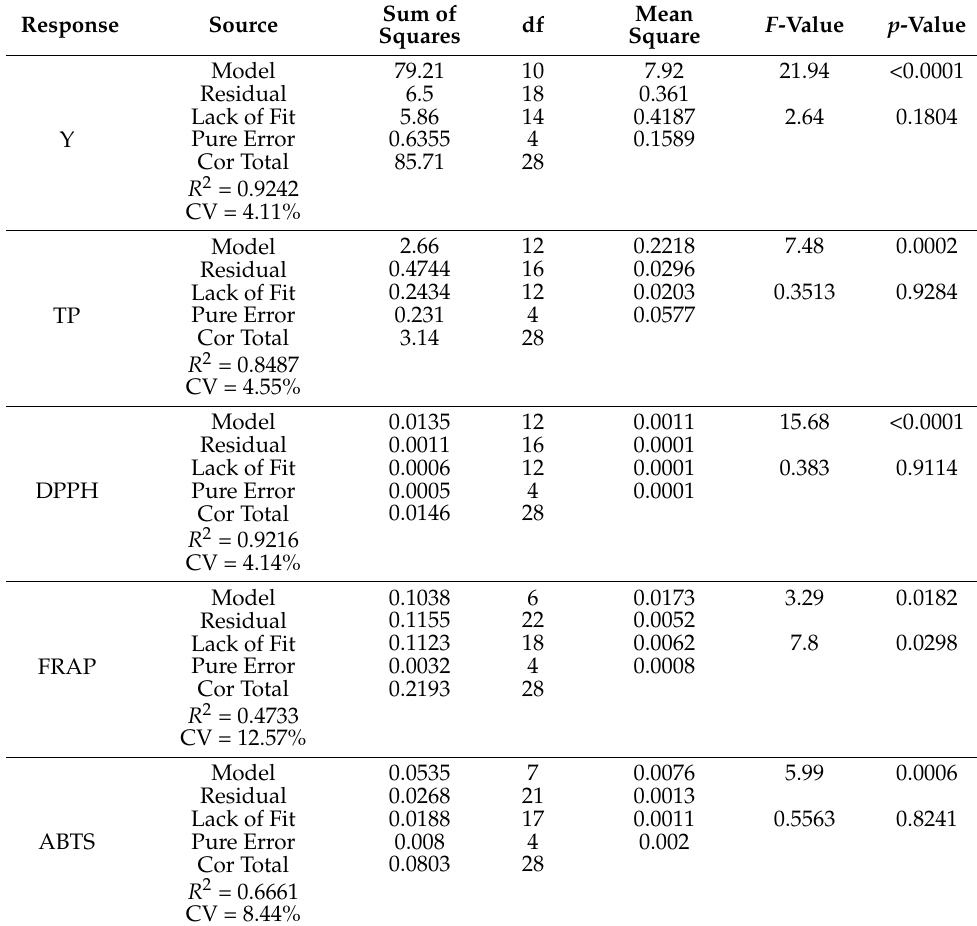
Table 3. ANOVA and descriptive statistics parameters for applied quadratic